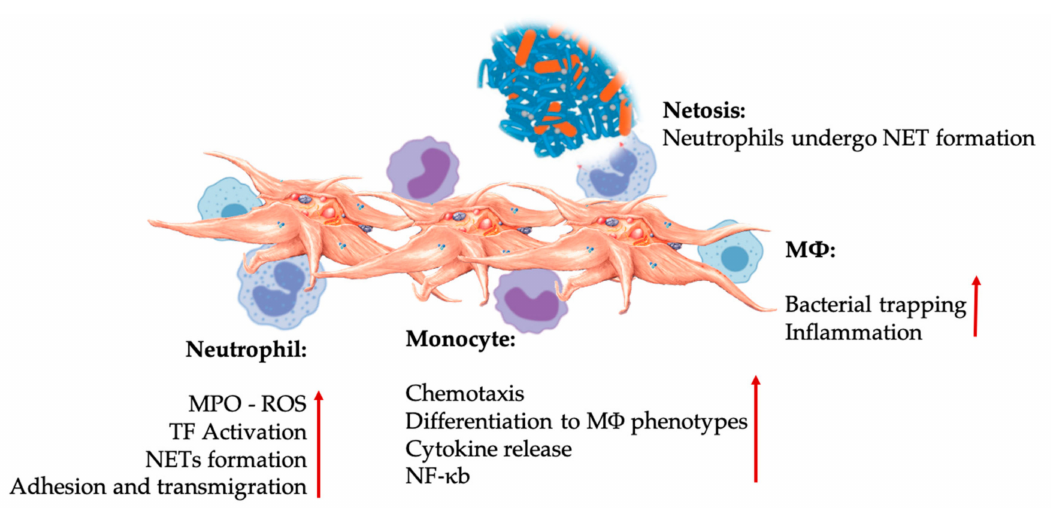
Figure 4. Platelet and leukocyte interactions in innate immunity cell interactions. Platelets interact with neutrophils, monocytes, and ultimately as well with M Φ s, modulating and increasing their e ff ector functions. These platelet-leukocyte interactions result in inflammatory contributions through di ff erent mechanisms, including NETosis [67]. Abbreviations: MPO: myeloperoxidase, ROS: reactive oxygen species, TF: tissue factor, NET: neutrophil extracellular traps, NF- κ B: nuclear factor kappa B, M Φ :